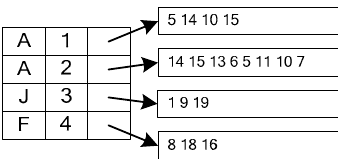
Figure 5. The candidate node set of Q in Figure 2.